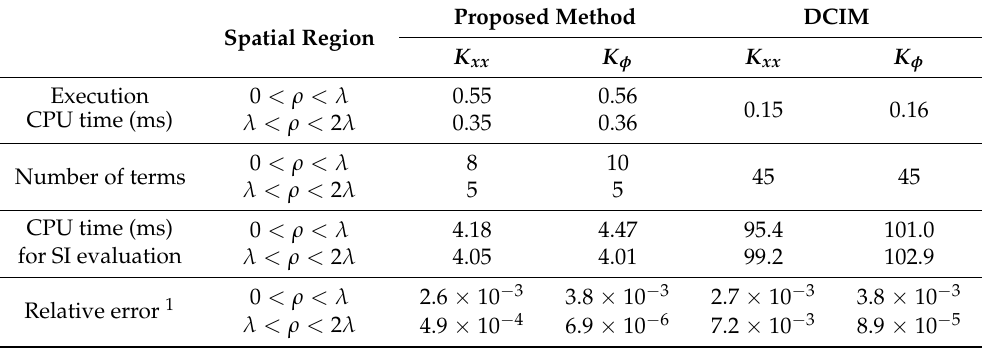
Table 2. Performance comparison for different SI approximation methods for a four-layer stacked